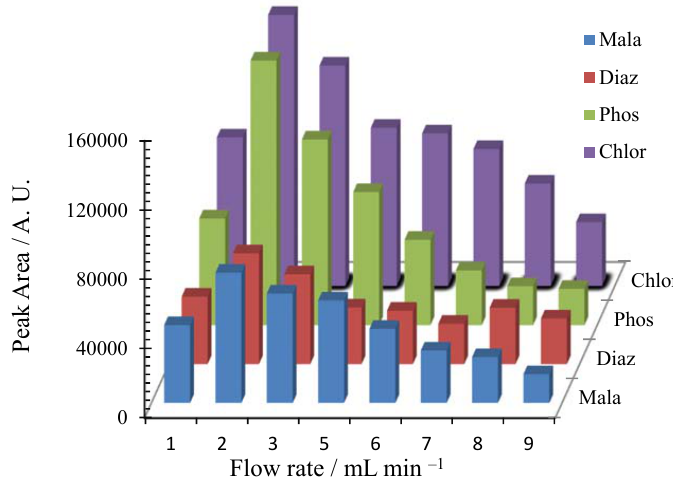
Fig. 4: Effect of sample loading flow rate on the extraction efficiency. Other conditions were as in Fig. Fig. 4